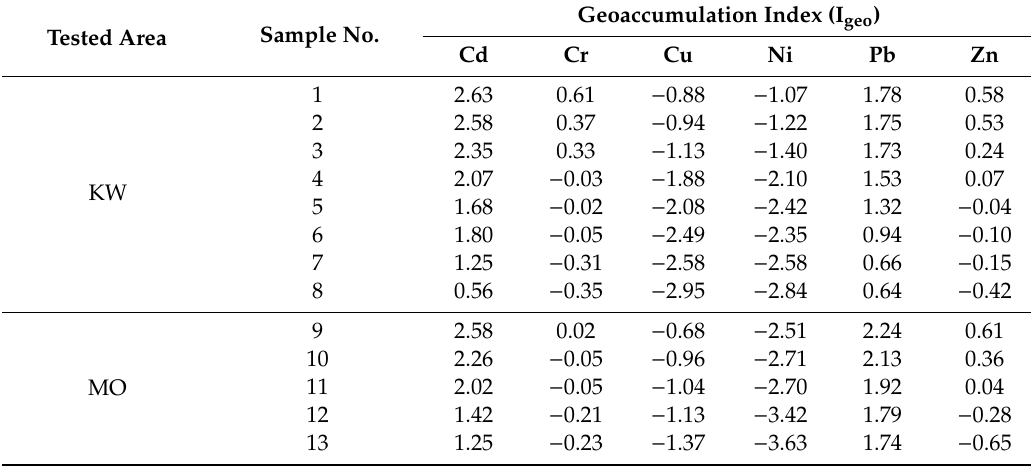
Table 5. Geoaccumulation index (Igeo) for soil samples from the Tatra National Park area (KW and MO). Geoaccumulation Index (I geo ) Tested Area Sample No. Cd